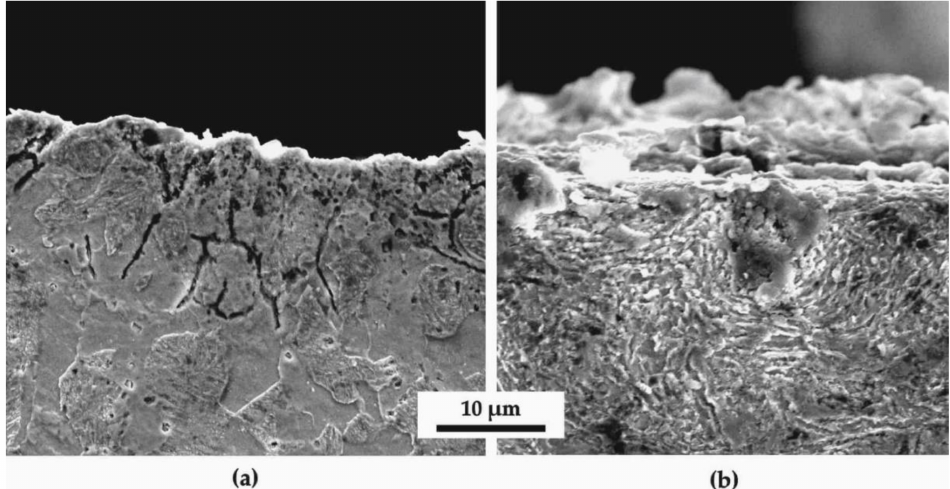
Figure 4. Scanning electron microscope (SEM) images of longitudinal sections close to the surface of the ( a ) HTT and ( b ) HTT+SSP at a magnification of 6000 ×